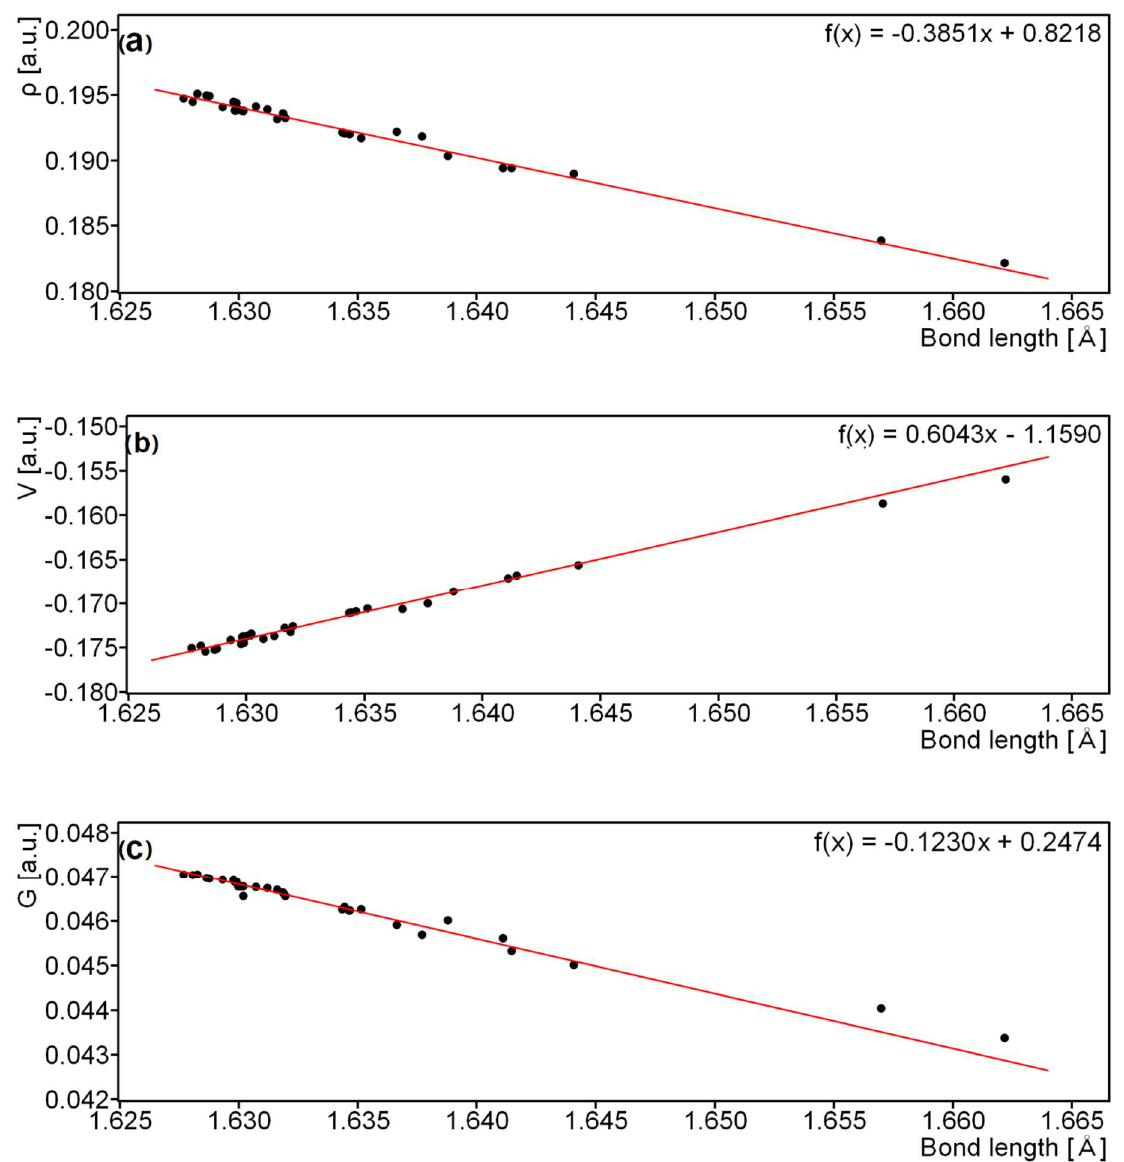
Figure 7. Electron density—( a ), potential-energy density—( b ) and kinetic-energy density—( c ) as a function of a single C-C bond length in the sennidin structures.